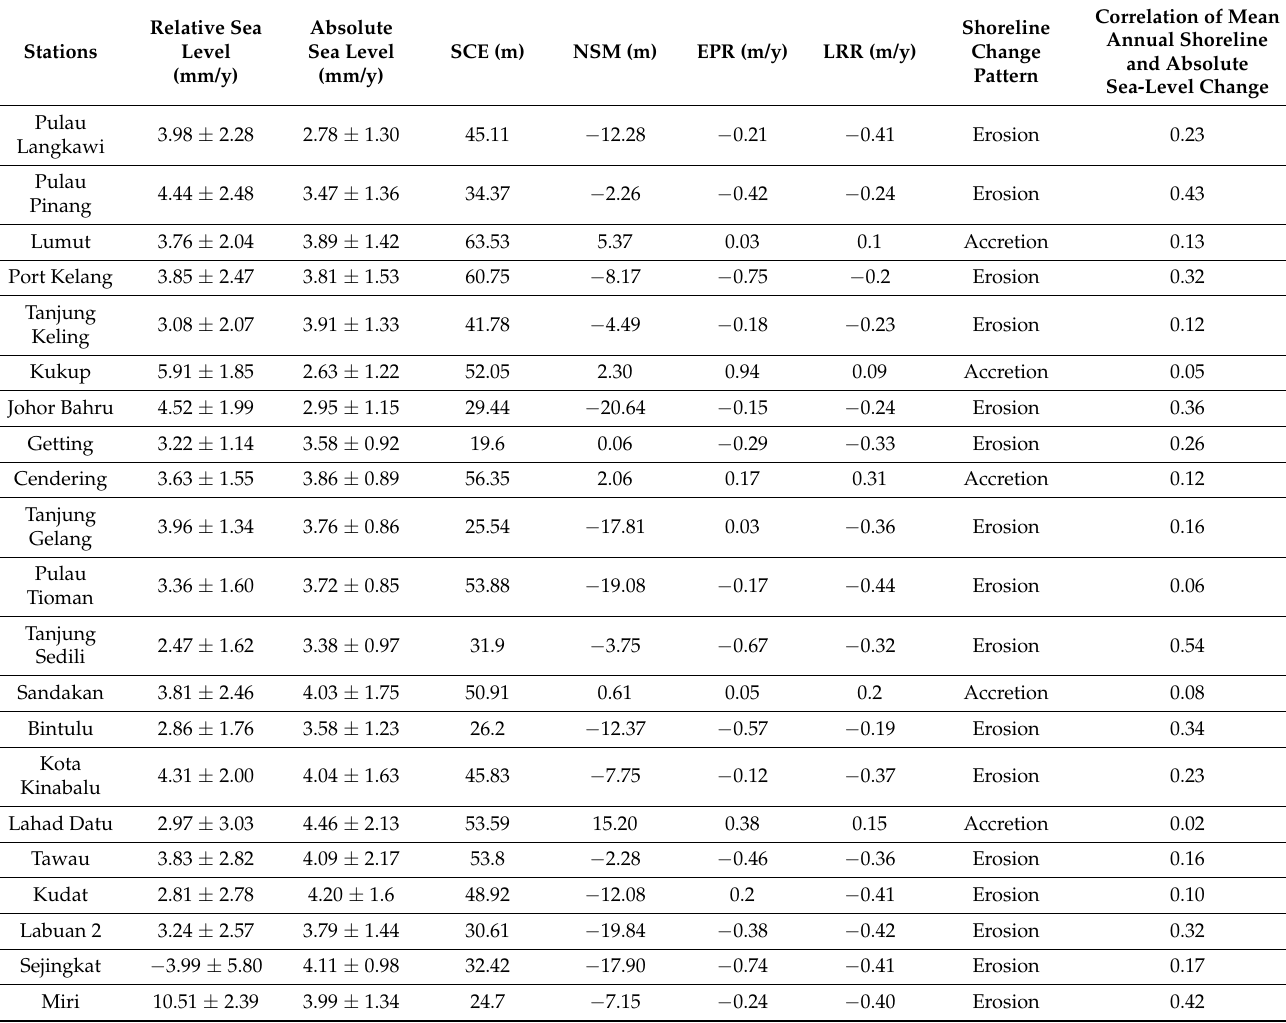
Table 4. Summary of trends in relative sea level, absolute sea level, and shoreline displacement at all tide-gauge sites in Malaysia.